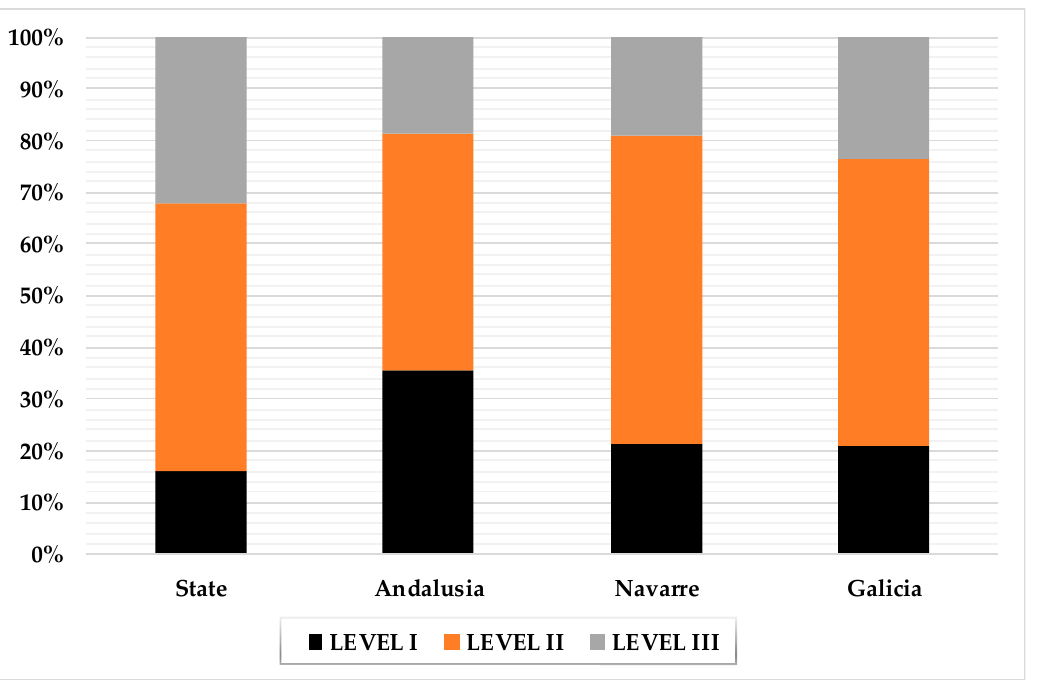
Figure 4. Curricular treatment of socioeconomic inequalities by administrative body and level of complexity (%).